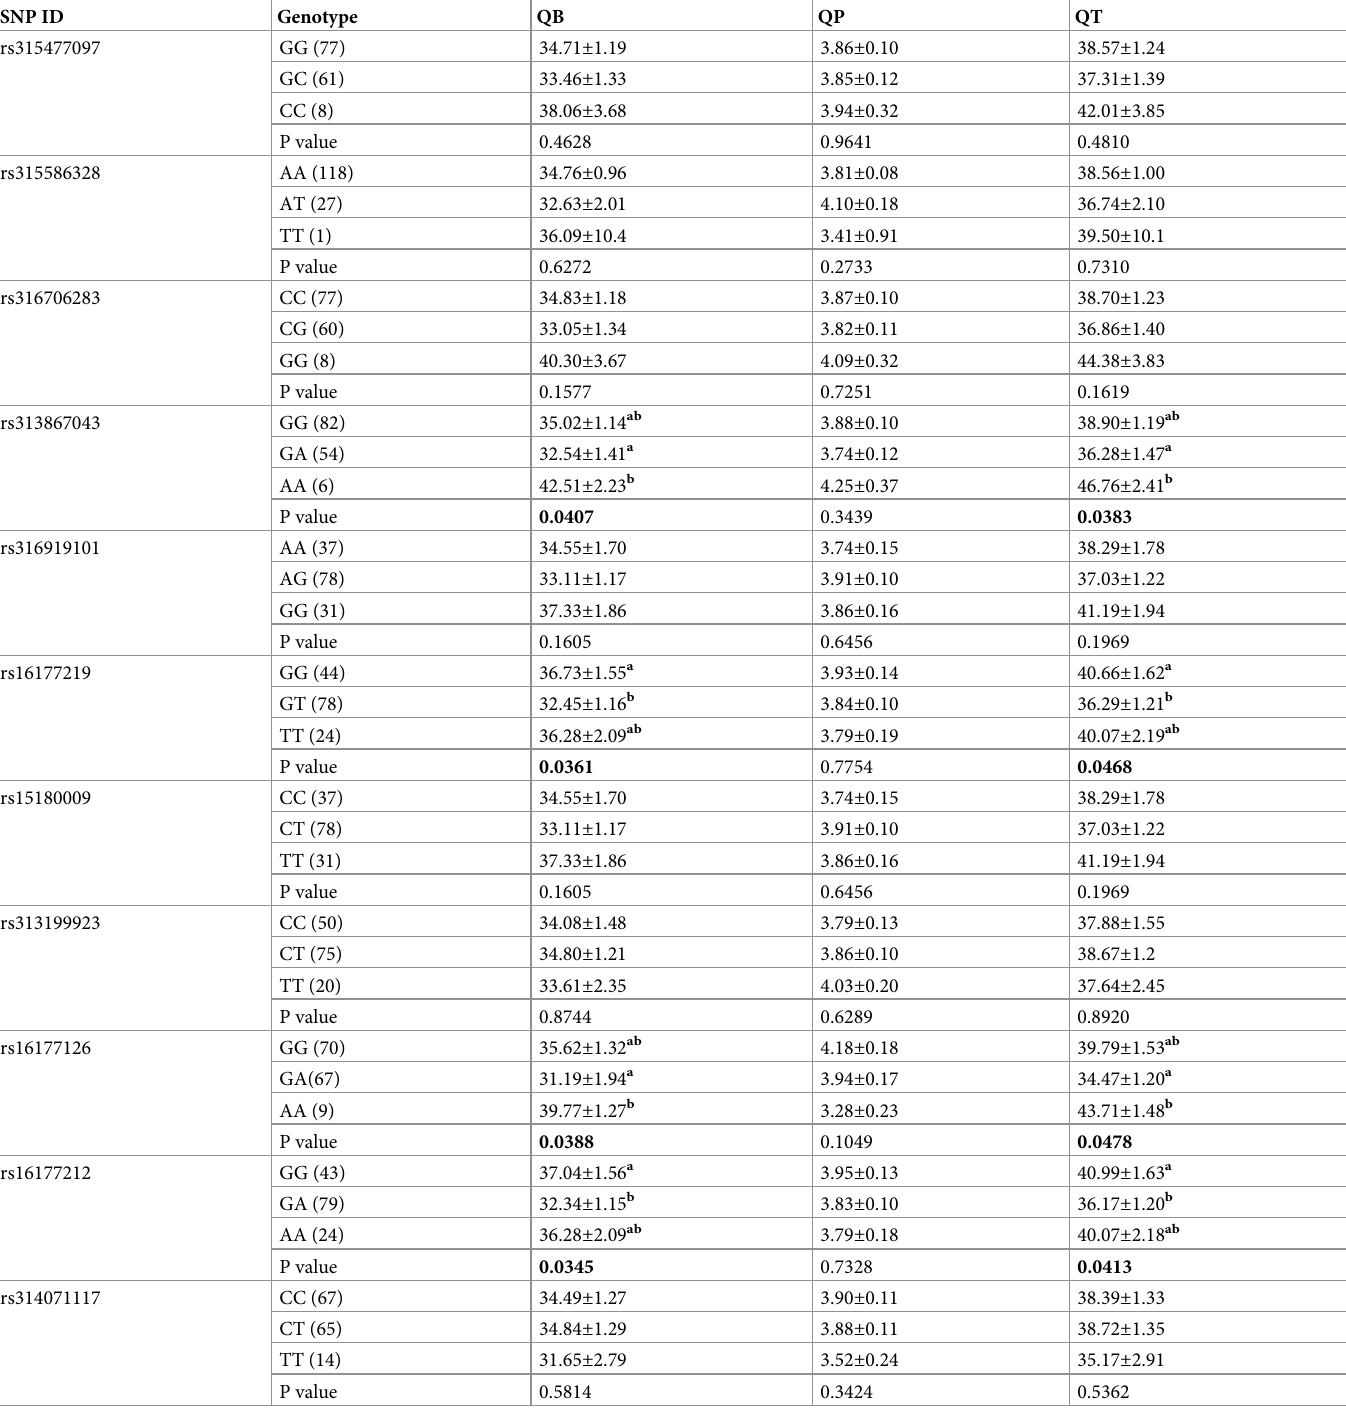
Table 6. Effect of 11 SNPs on eggshell color intensity trait in N146